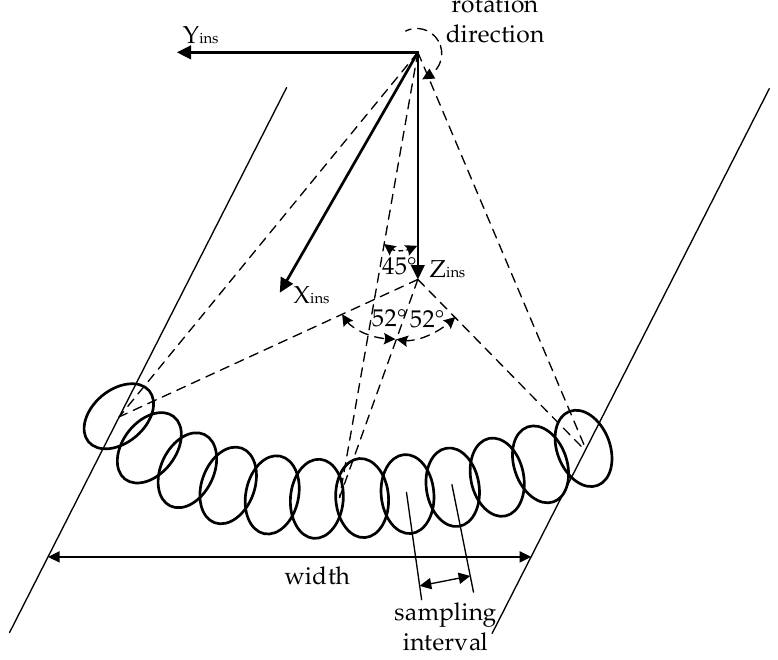
Figure 1. The scan geometry of the FY-3C MWRI.